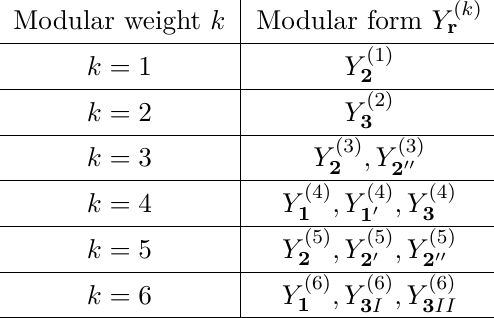
Table 13. Summary of modular forms of level 3 up to weight 6, the subscript r denotes the transformation property under T 0 modular symmetry. Here Y (6) independent weight-6 modular forms transforming in the representation 3 of T 0